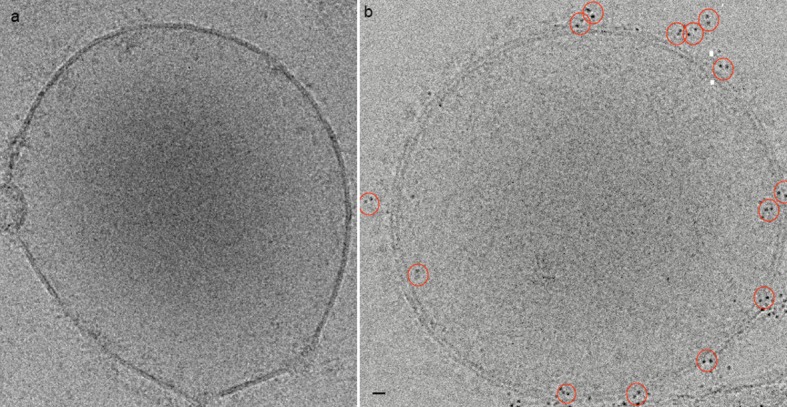
Cryo-EM images of membrane preparations treated with AuNP-FGF21 conjugate.Vesicles from AuNP-FG21 treated membrane preparations from (a) parental CHO cells, in which neither FGFR1c nor βKlotho are expressed and (b) human primary adipocyte cells, in which FGFR1c and βKlotho are endogenously expressed. Bar 10 nm.